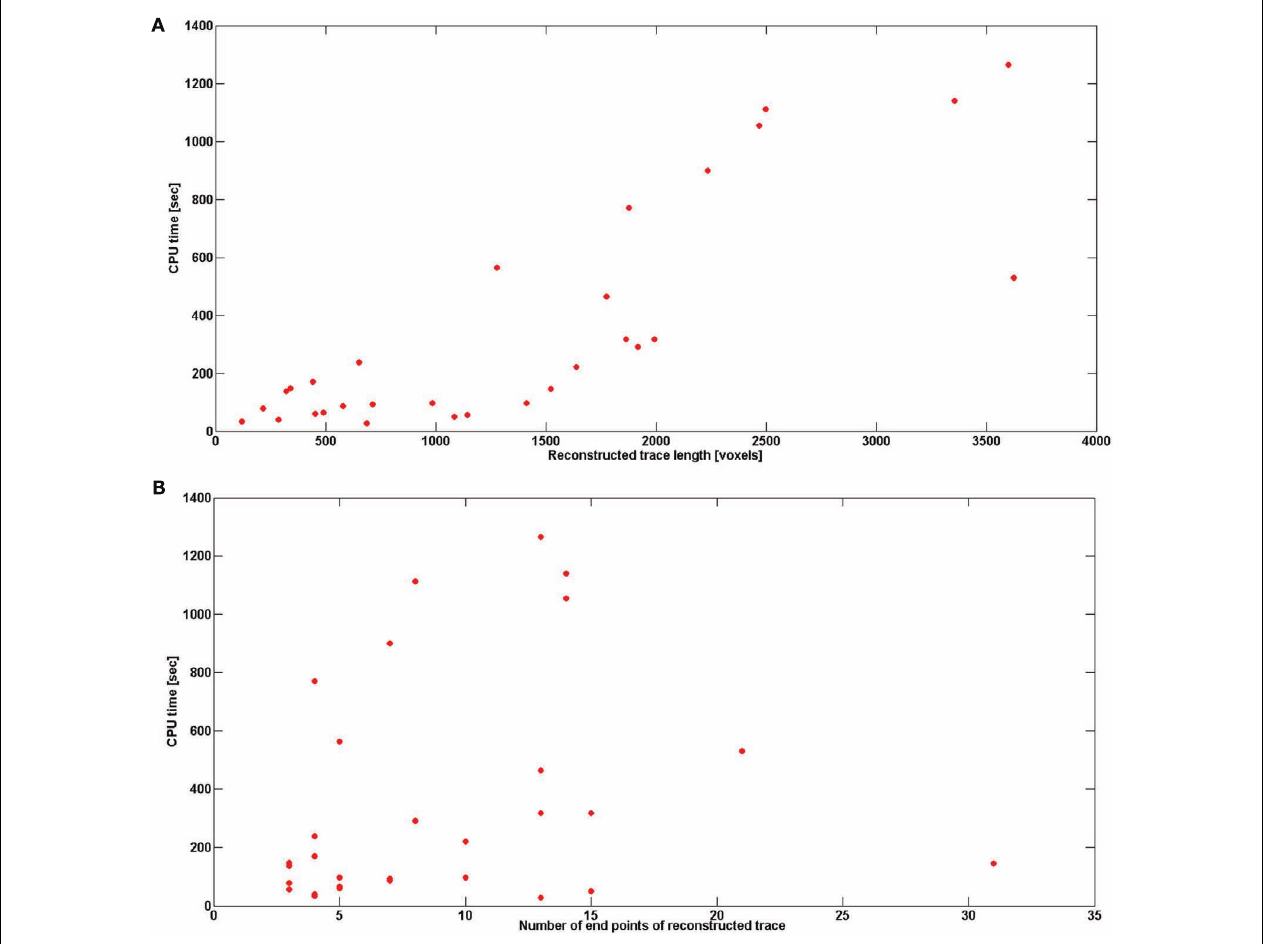
FIGURE 13 | (A) Reconstruction time in seconds with respect to the length of reconstructed trace. (B) Reconstruction time in seconds with respect to the number of end points of reconstructed trace.The results are averaged over the topologies obtained with noise levels: 0, 0.01, 0.03, 0.05, 0.07, 0.09, 0.1, and